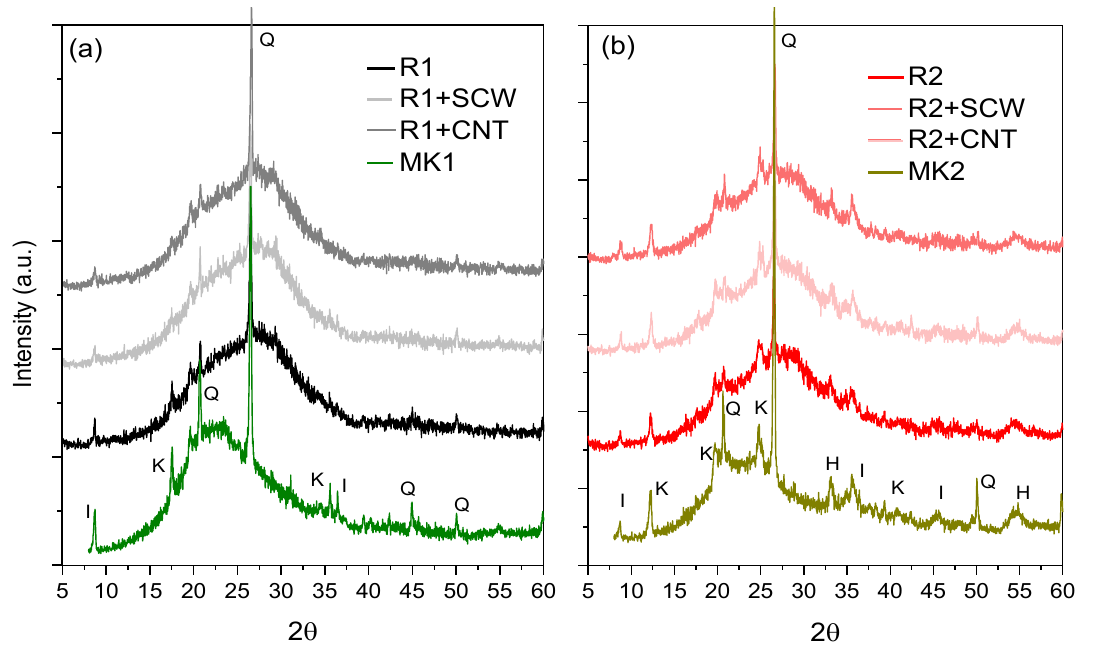
Figure 12. XRD spectrum of groups based on: ( a ) MK1; ( b ) MK2. Specifications: I—Ilite, K—kaolinite, Q—quartz, and H—hematite.